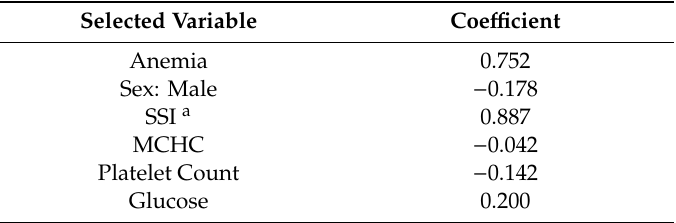
Table 4. Risk factors identified by the Lasso model and their associated coe ffi